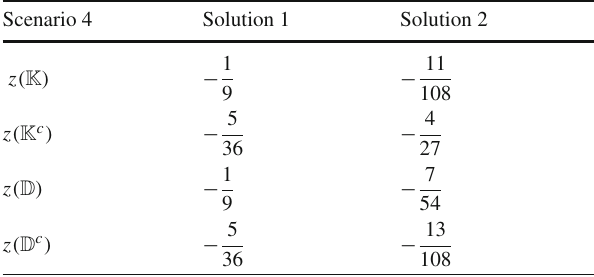
Table 12 The same as in Table 11, but for the hypercharges shown in Case 2 of Table 10 Scenario